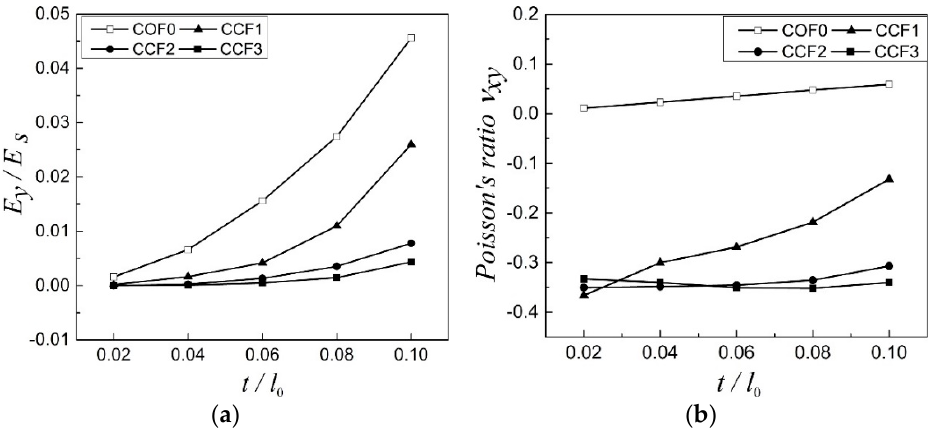
Figure 4. ( a ) The relative Young’s modulus E y / E s and ( b ) Poisson’s ratio ν xy vs. t / l 0 for h / l 0 = 0, 0.1, 0.2,